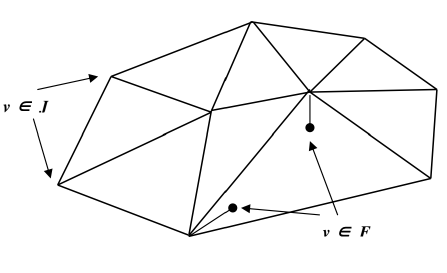
Figure 4. Off-Locations